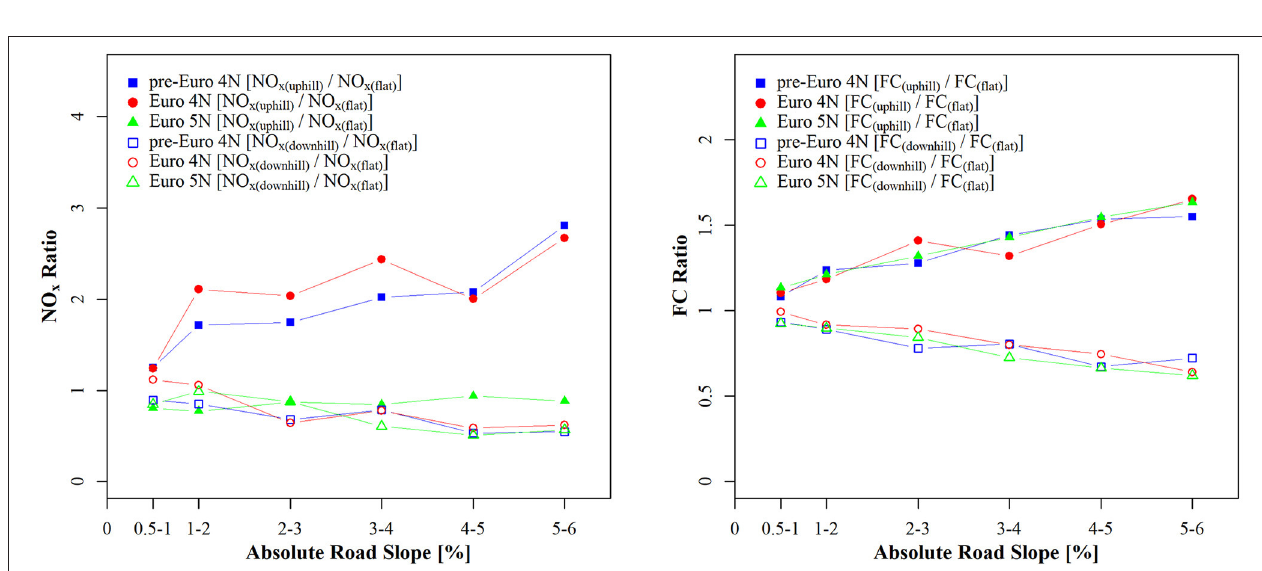
FIGURE 10 | NO x (left) and FC (right) ratios of uphill (slope > 0.5%) and downhill (slope < − 0.5%) road slope over flat road ( | slope | < 0.5%) as a function of absolute road slope classes for the various investigated technologies (distance-integration: 500m).